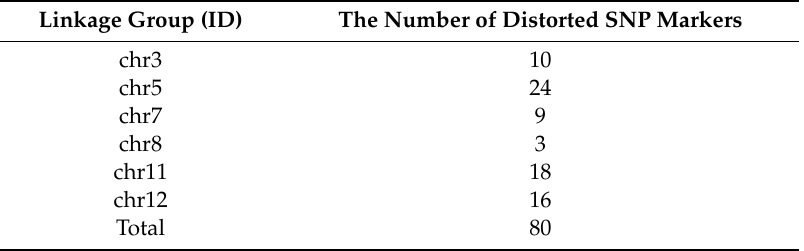
Table 4. The distorted SNP markers on integrated genetic map of tetraploid